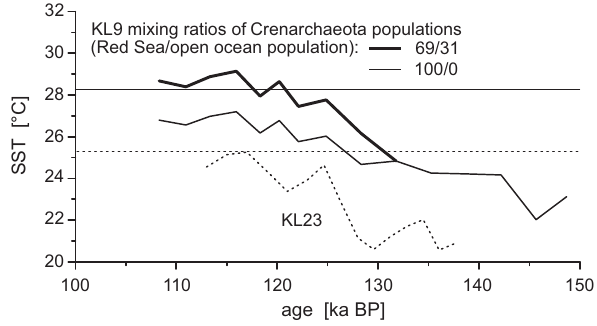
Fig. 9. TEX 86 -based SST interpretations. KL23 SST record (dot- ted line, horizontal dotted=modern SST at the core site) and KL9 SST signal interpreted as reflecting different mixing ratios of Red Sea versus open ocean Crenarchaeota population: 100% endemic Red Sea population (solid line) and after 130ka BP 69% endemic and 31% open ocean population (solid bold line, vertical solid line=modern SST at the core